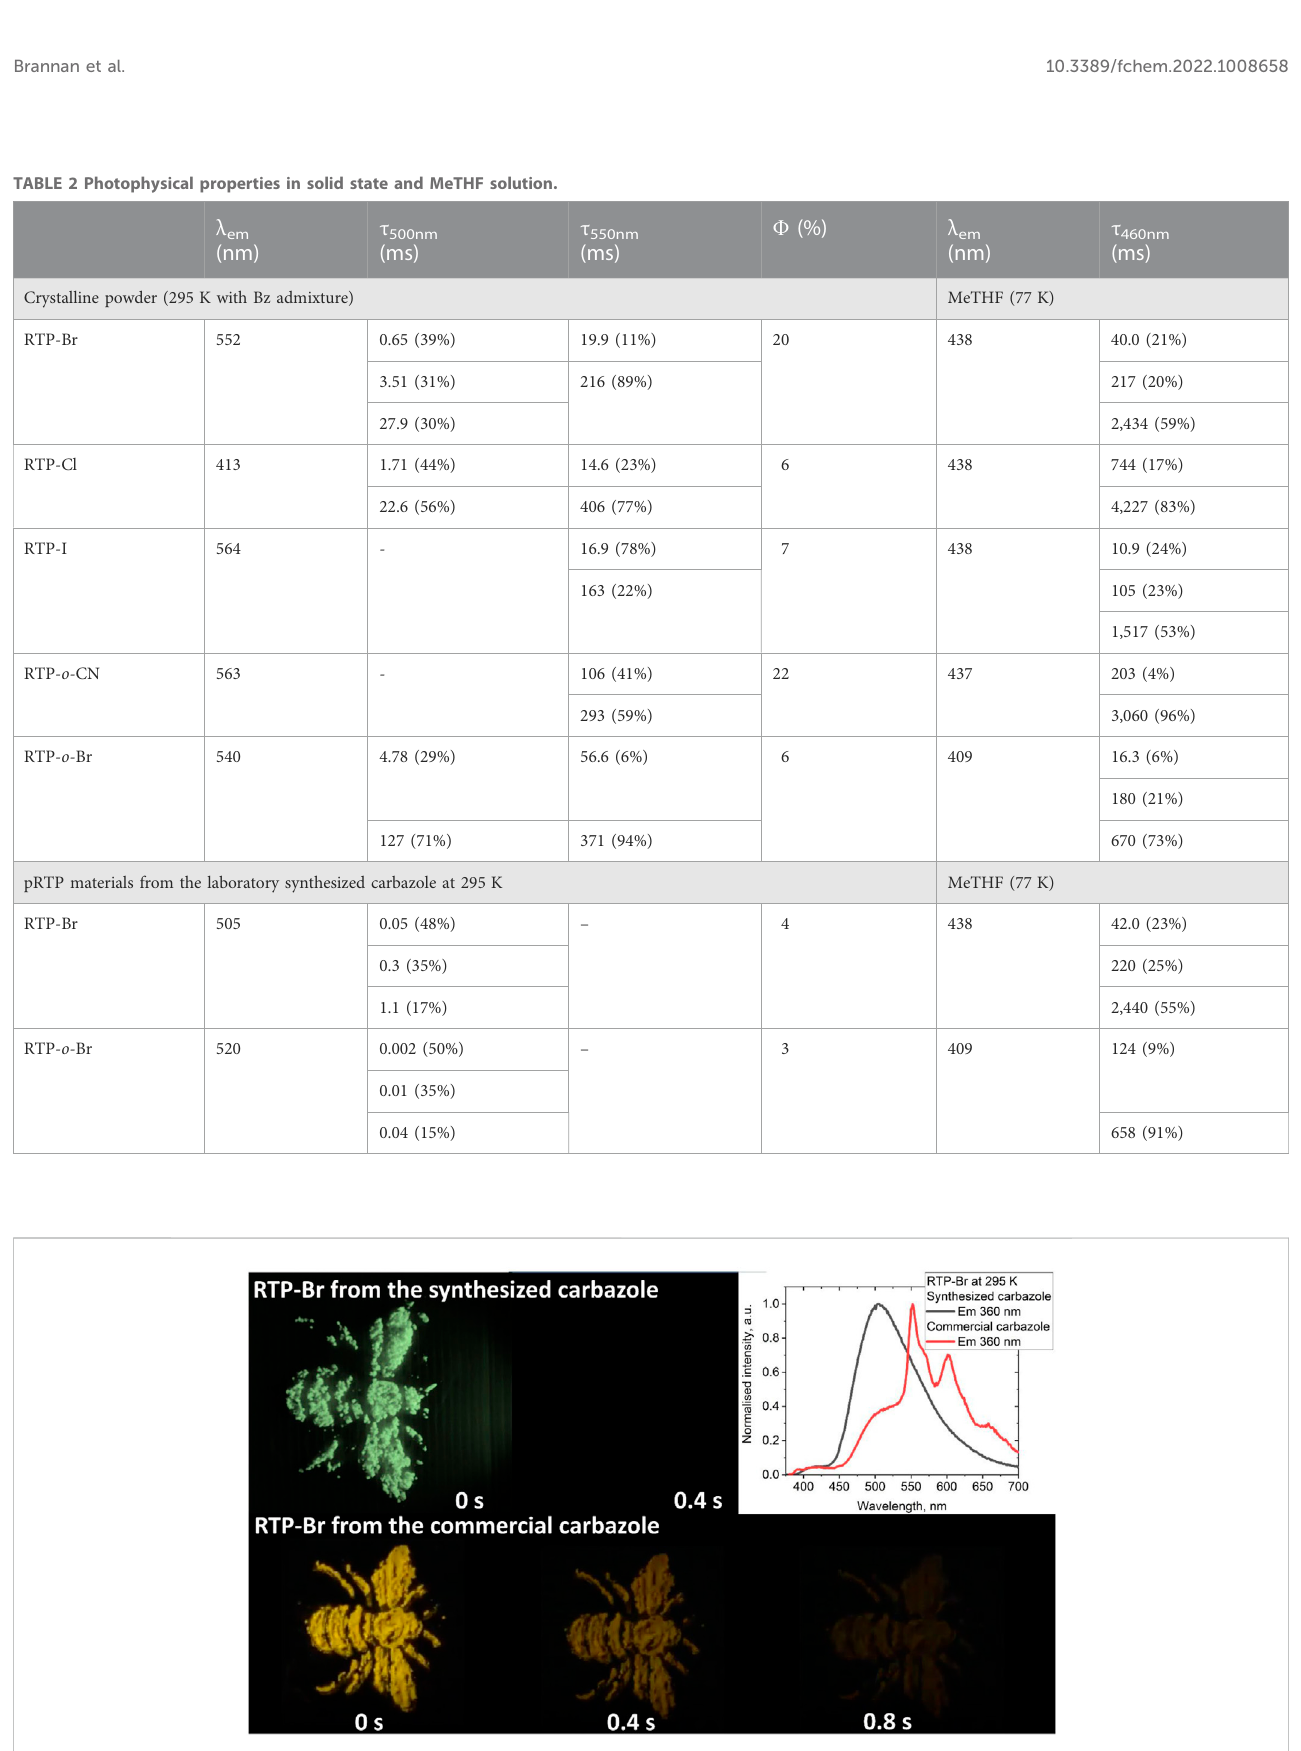
FIGURE 3 Bottom: complex RTP-Br obtained from the commercial carbazole sample (bottom, shows RTP property). Top: complex RTP-Br obtained from the synthesized carbazole (fast decay of the luminescence). All samples are exposed to 360 nm UV-light with top right panel showing difference in the luminescence pro fi